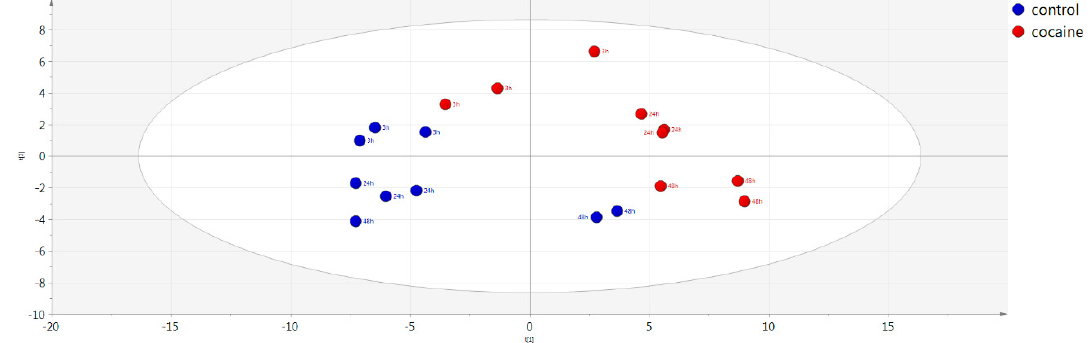
Figure 7. PCA model showing control (blue) vs. cocaine-treated (red) cell medium samples. Table 3. Model characteristics of PCA and OPLS-DA multivariate analysis.